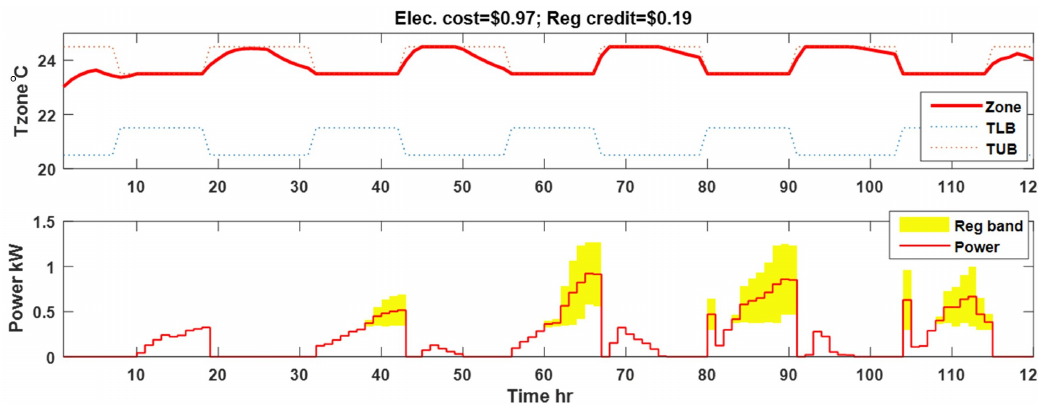
Figure 8. BaseControl I